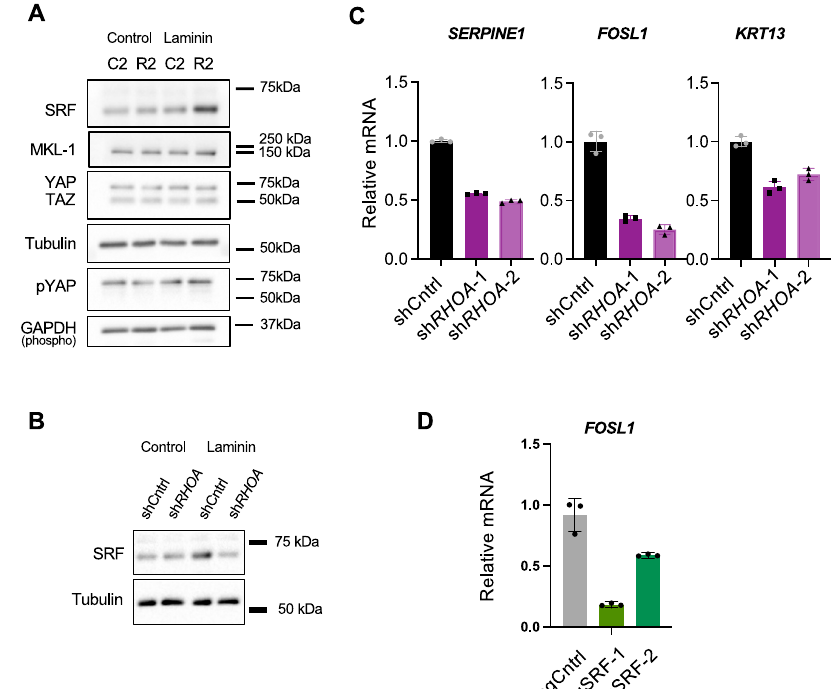
Fig.7|RhoAcontrolsSRFproteinlevelsandtheexpressionofbrainmetastasis and drug resistance genes. A C2 or R2 cells were cultured over 18 days in the presence of osimertinib on control or laminin-coated plates. Lysates were then subjectedtowesternblottingfortheindicatedproteins.Arepresentativeblotfrom two independent experiments is shown. B R2 cells expressing the indicated shRNAswere cultured asin A . Lysates were then subjectedto westernblotting for SRFortubulin.Arepresentativeblotfromtwoindependentexperimentsisshown. C R2cellsexpressingtheindicatedshRNAswereculturedonlaminin-coatedplates